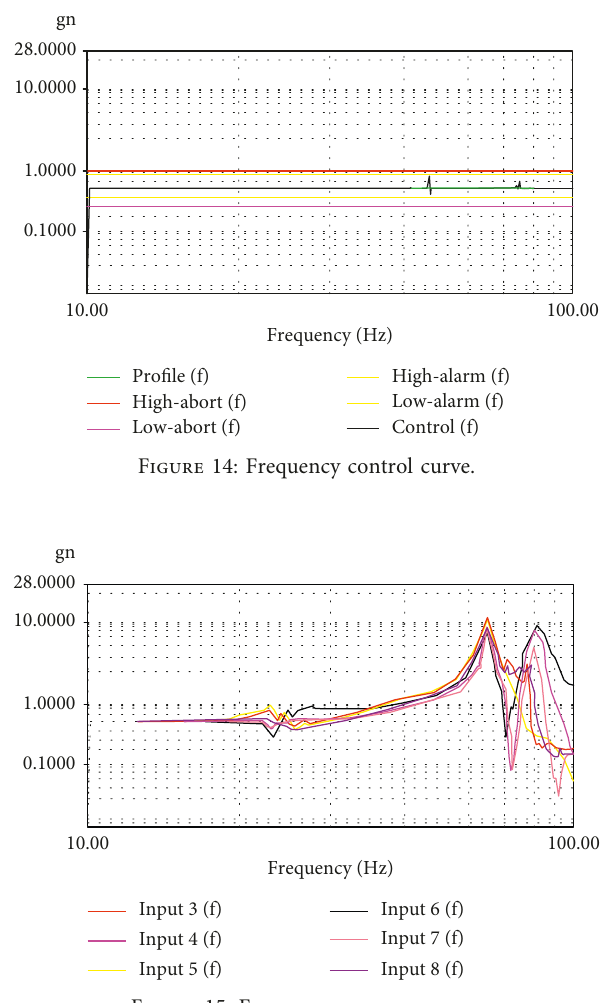
Figure 15: Frequency response